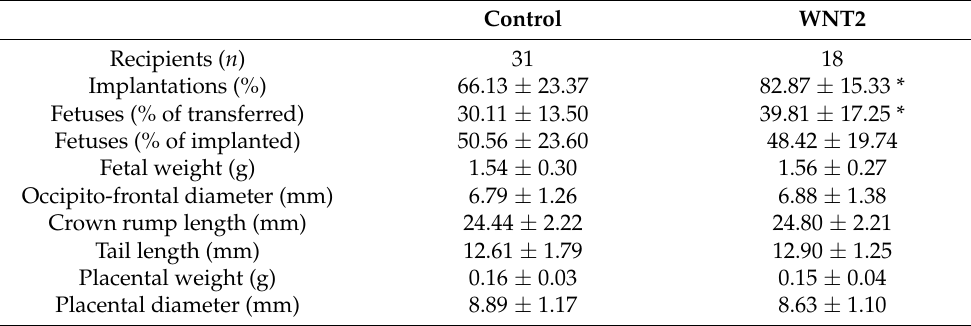
Table 1. Pregnancy outcomes of IVF blastocysts treated with WNT2 at E19.5. The mice were sacrificed at E19.5, and the fetuses were collected to measure all